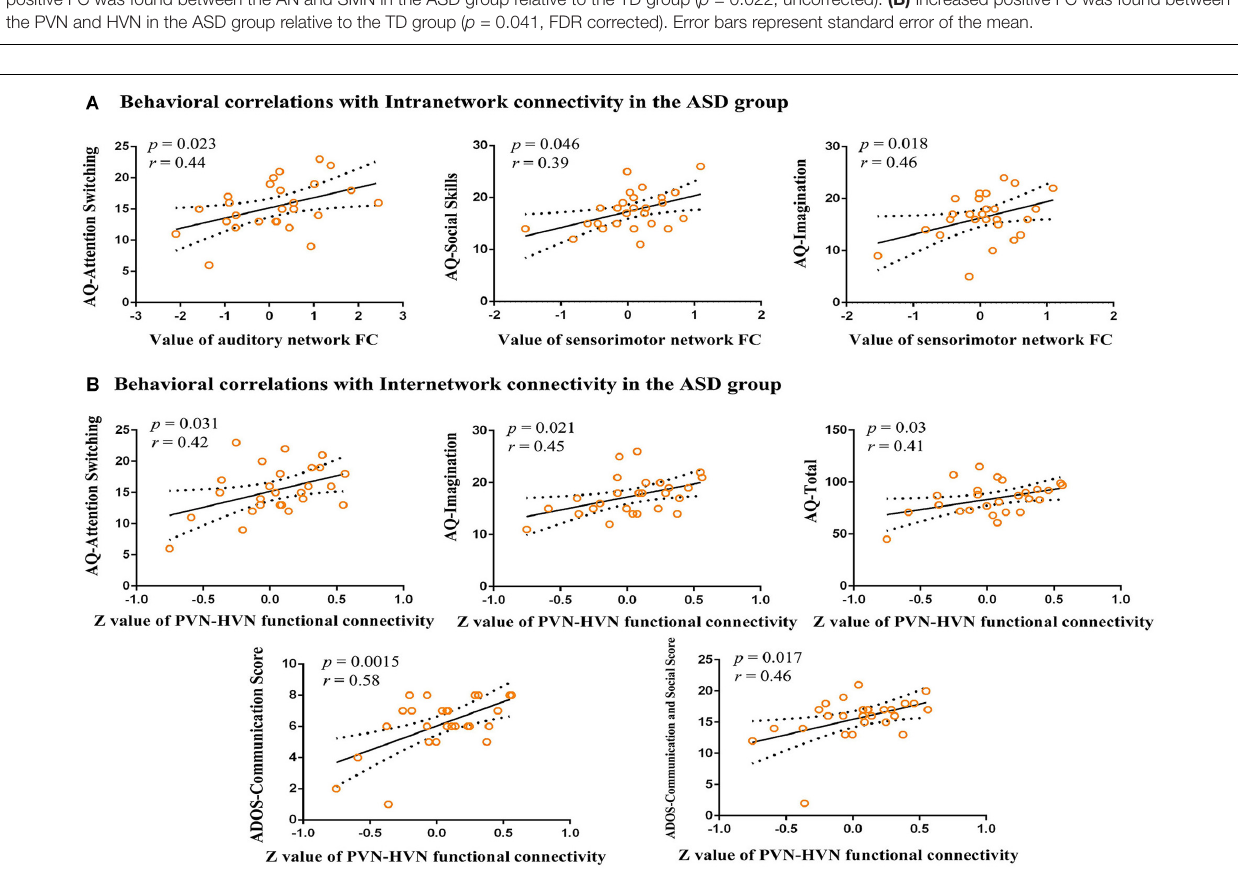
FIGURE 4 | Correlations between functional connectivity and behavioral scores. (A) Behavioral correlations with intranetwork connectivity in the ASD group. Scatter plots show significant ( p < 0.05) positive correlations between aberrant intranetwork connectivity and AQ scores. (B) Behavioral correlations with internetwork connectivity in the ASD group. Scatter plots show significant ( p < 0.05) positive correlations between mean Z- values of aberrant internetwork connectivity and AQ scores and ADOS scores. AQ, Autism Spectrum Quotient Children’s Version; FC, functional connectivity; ADOS, Autism Diagnostic Observation